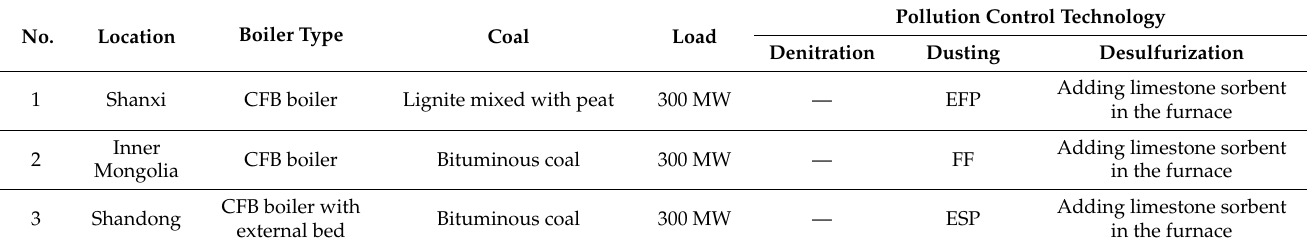
Table 1. Basic situation of three CFB boilers.